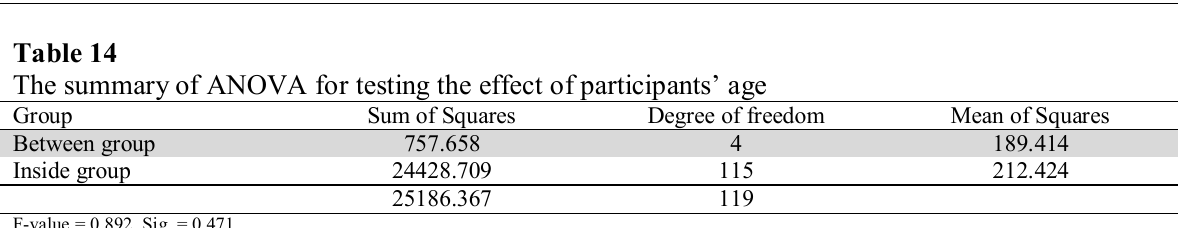
The summary of mean and standard deviation of social capital and participants’ age Variable 20-30 31-40 41-50 51-60 Mean Std. dev. Mean Std. dev. Mean Std. dev. Mean Std. dev. Relational 3.09 0.928 3.28 0.833 0.751